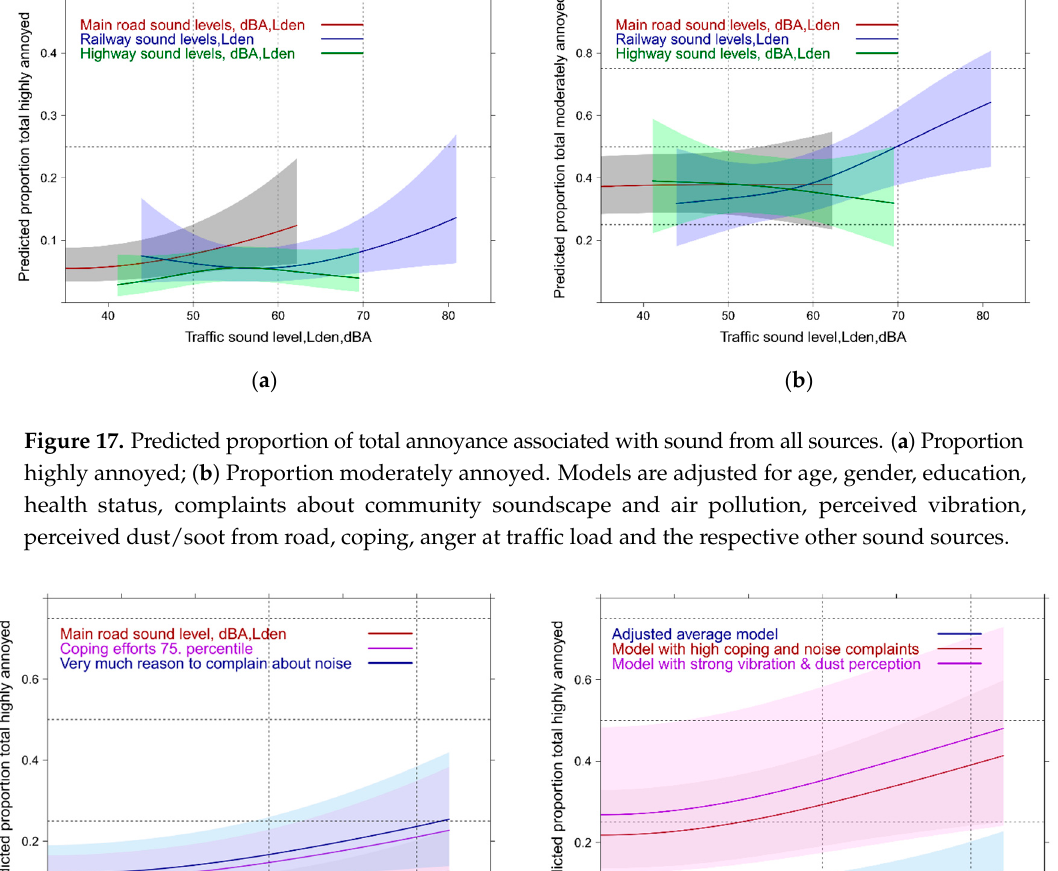
Figure 17. Predicted proportion of total annoyance associated with sound from all sources. ( a ) Proportion highly annoyed; ( b ) Proportion moderately annoyed. Models are adjusted for age, gender, education, health status, complaints about community soundscape and air pollution, perceived vibration, perceived dust/soot from road, coping, anger at traffic load and the respective other sound sources.